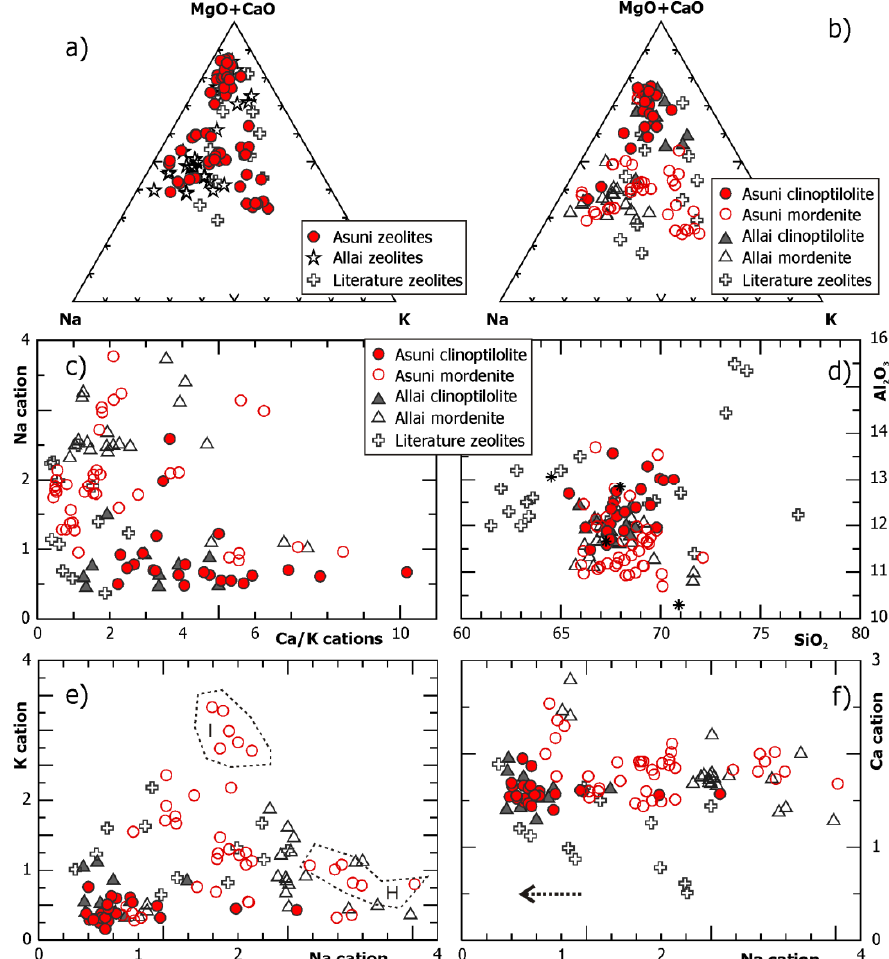
Figure 8. Zeolite composition of the Asuni samples plotted into triangular diagrams (Ca + Mg)-Na-K ( a,b ) and binary diagrams of measured content in cations ( c,e,f ) and oxides ( d ) and compared with literature data [25,53,55]; the arrow shows main trend along sequence. The plots allow the comparison with literature on clinoptilolite and mordenite chemistry, namely, from Allai Unit [30] and other Si-rich zeolites worldwide. Errors are within symbol size.